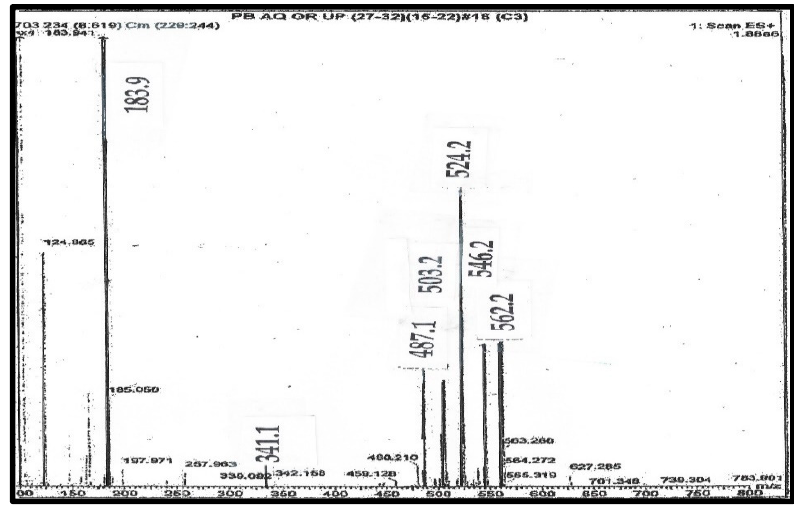
Figure 3. Mass spectrum of purified C341 from pig blood.